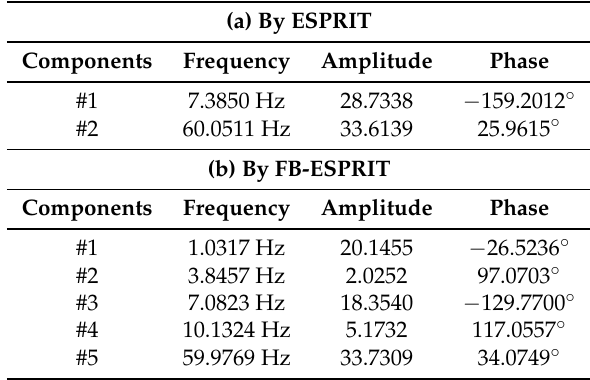
Table 10. Estimated parameters of the UFJF PV power plant current signal components by (a) ESPRIT and (b) FB-ESPRIT.